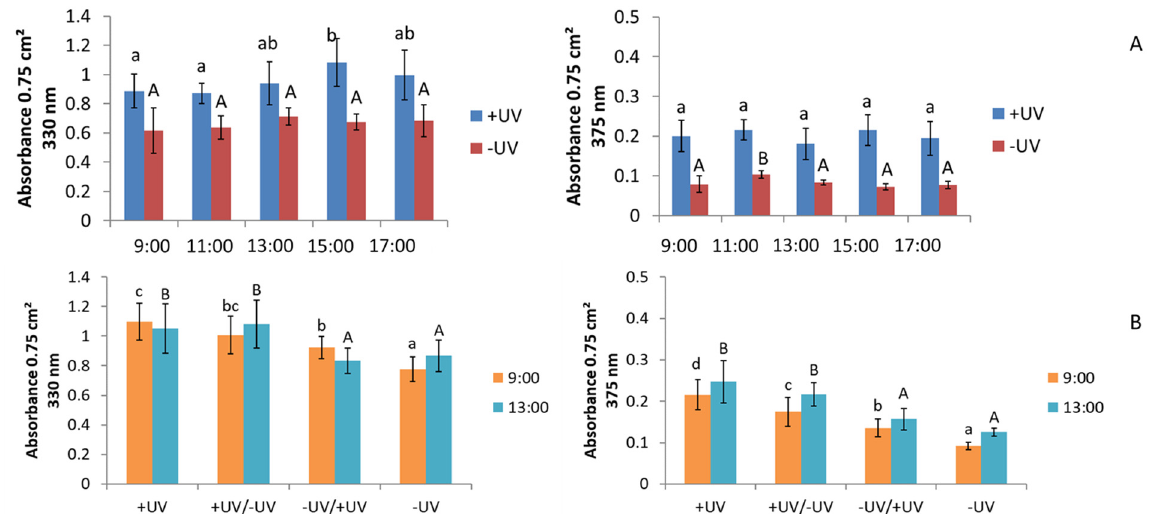
Figure 2. Absorbance of okra plant extracts at 330 nm and 375 nm dependent on ( A ) the diurnal rhythm (Experiment 1—targeting diurnal rhythm) and ( B ) the UV conditions at transfer and harvest times of 9:00 and 13:00 with a 7-day adaption period after the transfer (Experiment 2—targeting changes in diurnal rhythm due to transfer to the opposite UV condition). Different letters represent significant differences at p ≤ 0.05.